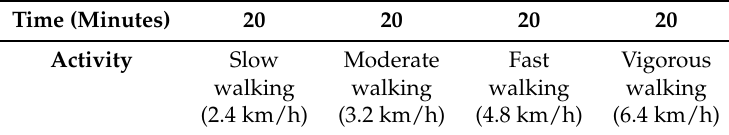
Table 2. The Treadmill Walking Activity